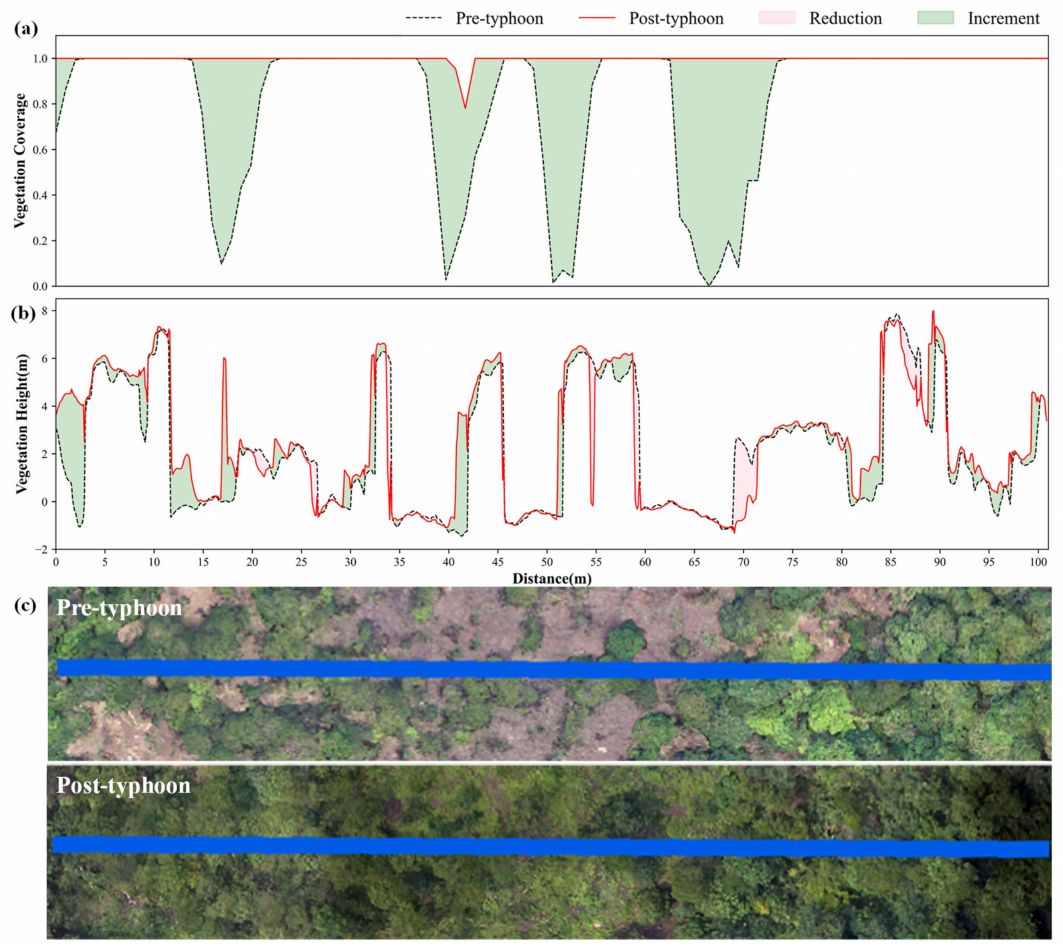
Figure 7. Changes in coverage and canopy height of the natural forest on the sampling line before and after the typhoon. ( a ) The vegetation coverage; ( b ) the canopy height; and ( c ) the sampling